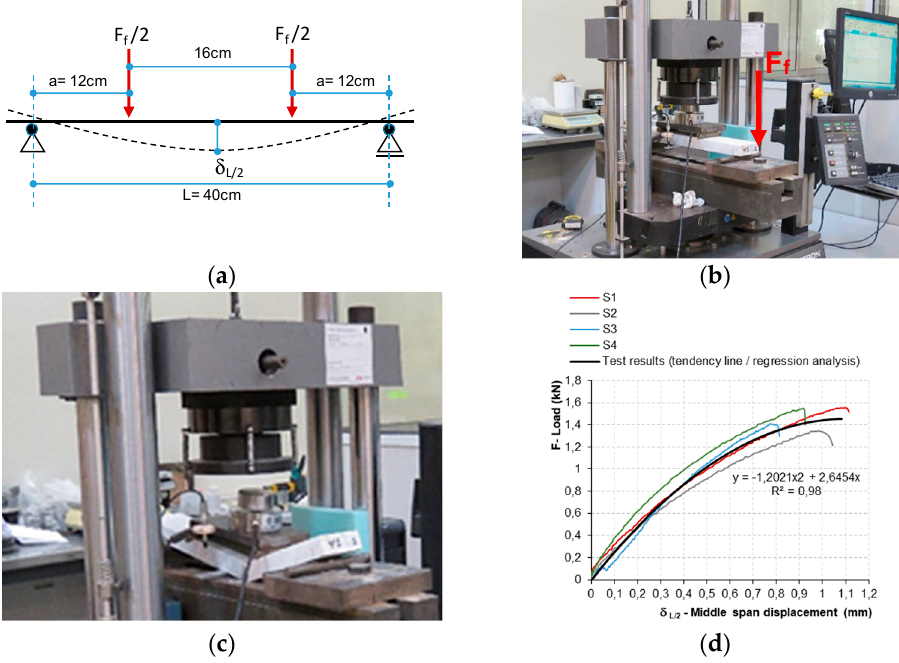
Figure 6. Examples of flexural strength and static modulus of elasticity lab tests (top side of the specimen is the sun/wind-exposed surface): ( a ) static model of the test; ( b ) test set-up with loading direction (F); ( c ) specimen after breaking load; ( d ) force-displacement curves and regression analysis.